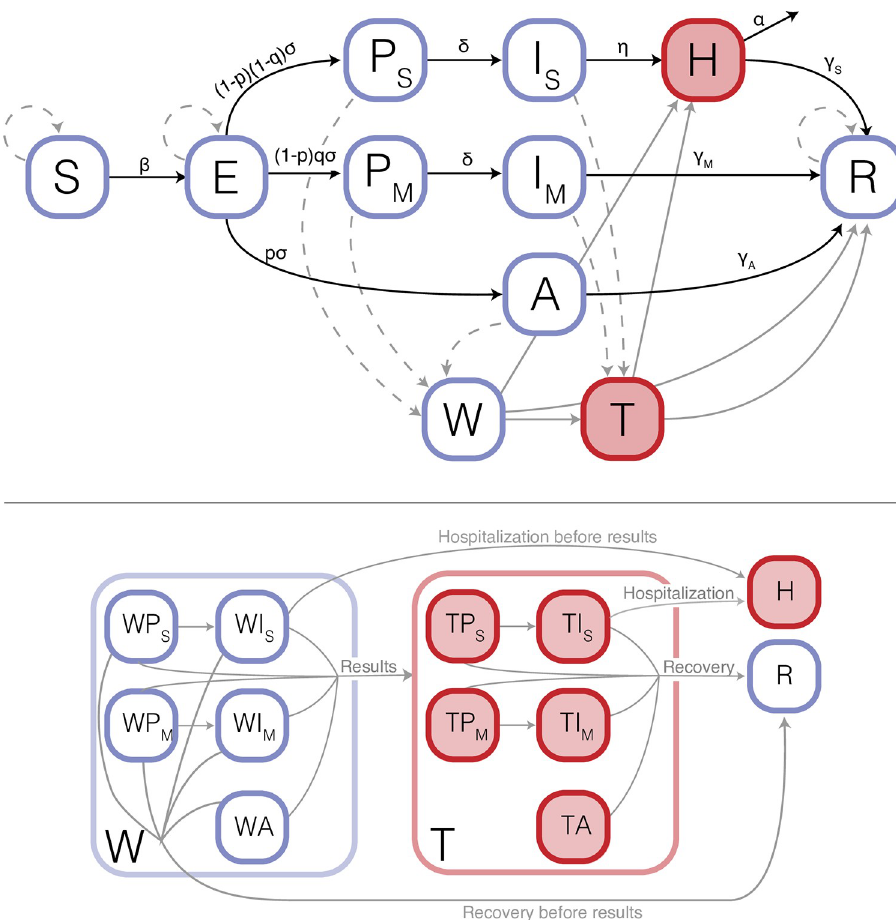
Fig 1. Compartmental structure of the model. Individuals are classified by epidemiological and testing state (S: susceptible, E: exposed, P S and P M : presymptomatic transmission for severe and mild infections, respectively, I S and I M : symptom reporting for severe and mild infections, respectively, A: asymptomatic infection, H: hospitalized, W: awaiting test results, T: isolated, R: recovered). Pathogen transmission occurs between non-isolated, infected individuals (P, I, A, and W classes) and susceptible individuals (S class). Red filled compartments are isolated, and thus are assumed to not contribute to onward transmission of the pathogen. Solid lines show epidemiological transitions, with parameters to define the rate of transition (see S1 Appendix for full list of transition rates and Table 1 for parametric assumptions). Dashed lines show transitions made through testing, and grey lines show transitions out of waiting and testing classes. The W and T classes are a set of compartments broken down by infection status of tested and isolated individuals respectively (expanded in bottom half of figure). Individuals that report symptoms (I classes) isolate upon test administration, whereas randomly tested individuals await results in the W classes, where they can (1) develop and report symptoms (i.e., move from W P to W I ), (2) recover or become hospitalized before they receive test results, or (3) receive test results and isolate. Individuals remain isolated until